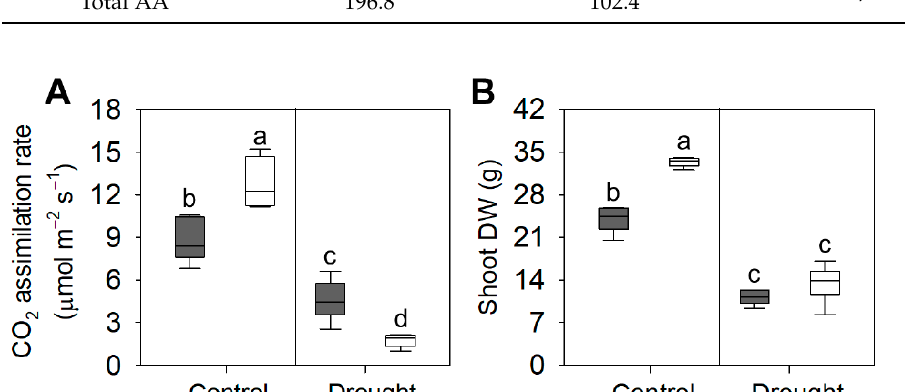
Figure 9. Response of AN1 (grey boxes) and WT plants (white boxes) grown under control and drought condition. ( A ) CO 2 assimilation rate; ( B ) Shoot dry weight. Tukey post-hoc test was performed on significative differences according to two-way ANOVA ( p < 0.05). Different letters indicate significant